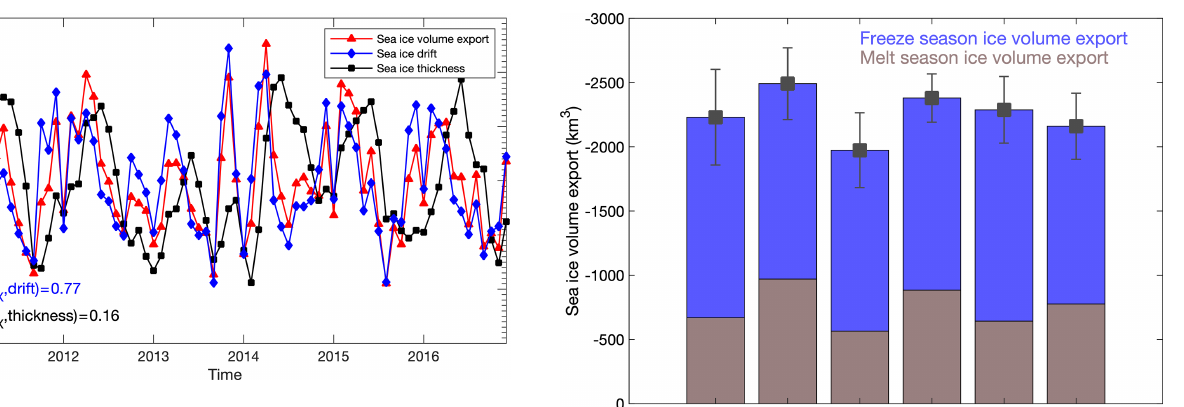
Figure 11. Time series of standardized monthly mean sea ice vol- ume export ( Q EX , red line) and corresponding monthly mean sea ice drift (blue line) and sea ice thickness (black line), including cor- relation of determination ( R 2 ).